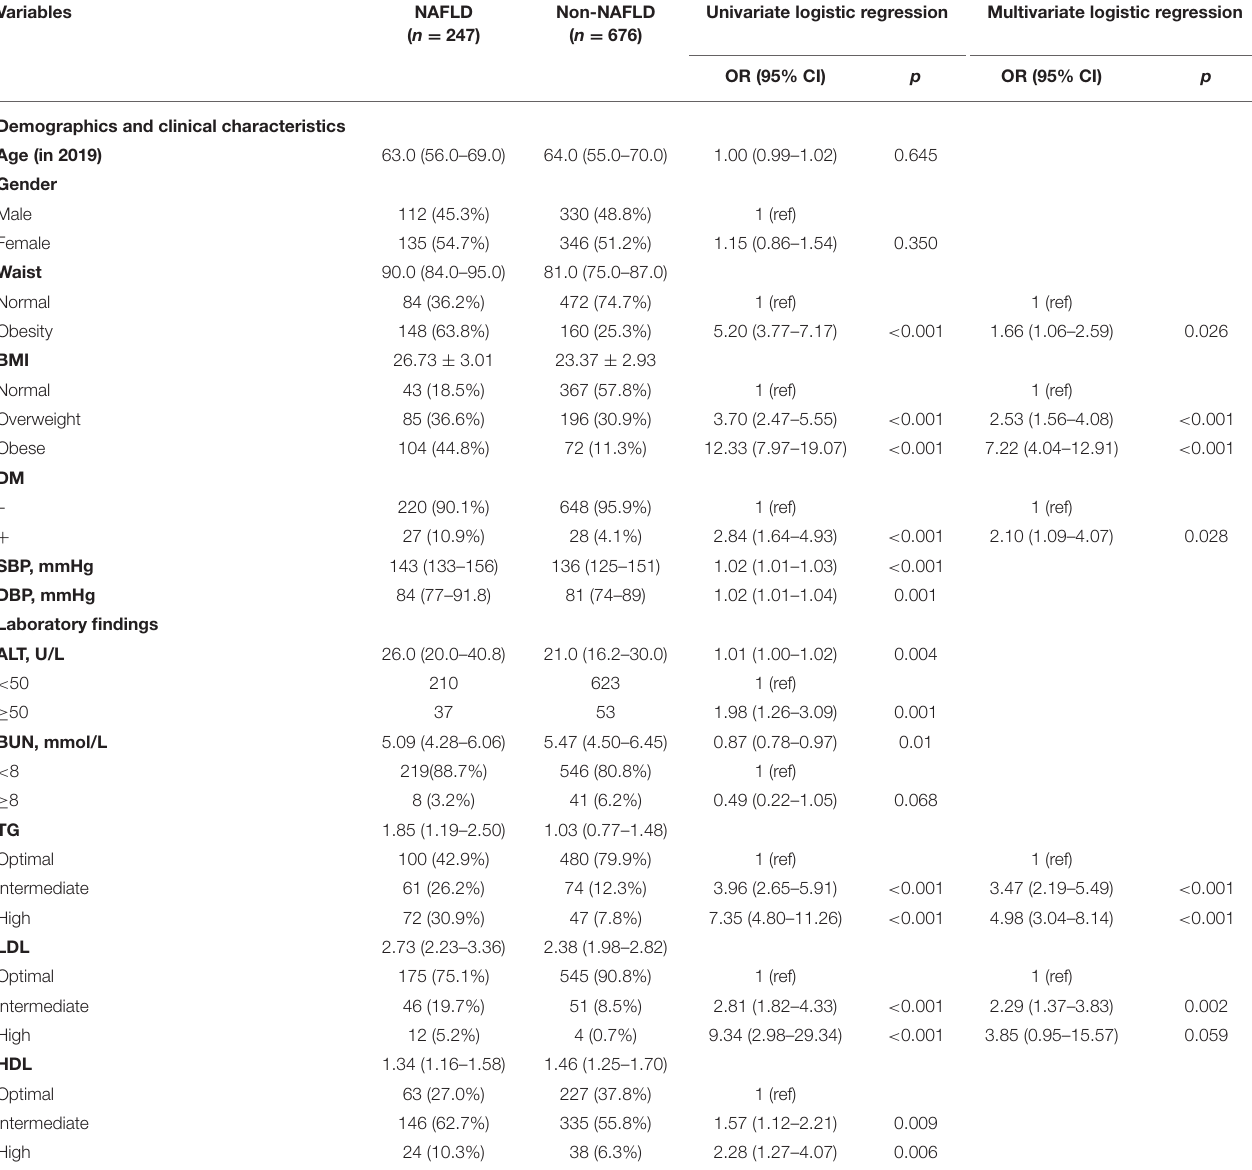
TABLE 1 | Risk factors associated with the prevalence of NAFLD.